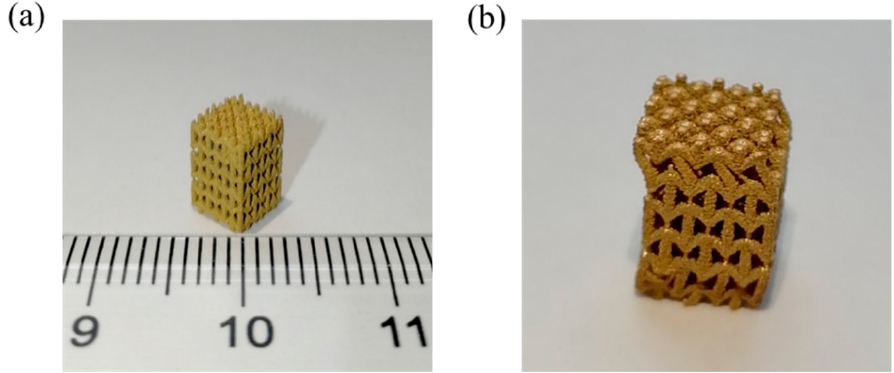
Figure 10. Micro scaled 3D auxetic structure. ( a ) Before compression test ( b ) After compression test